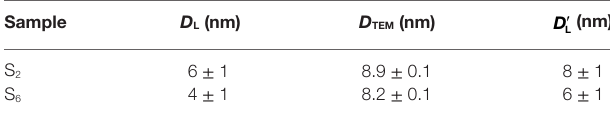
TaBle 2 | Values of nanoparticle size obtaining from TeM study ( D TeM ), from eq. 2 ( D l ), and by including the capping thickness ( s 2 and s 6